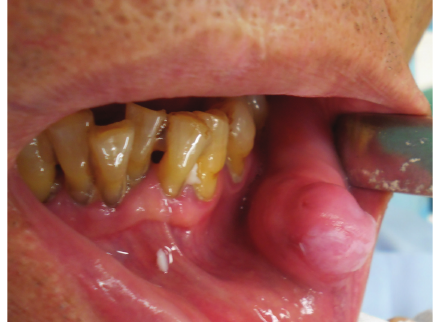
Figure 1: Preoperative intraoral view showing a solitary swelling in the buccal mucosa.